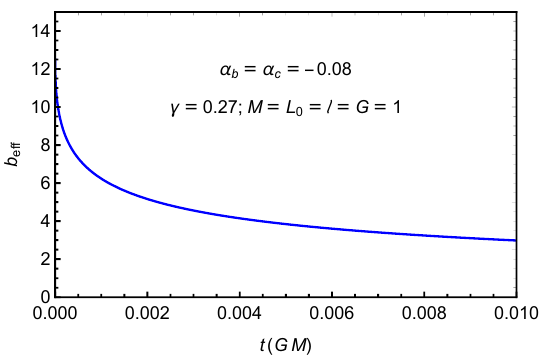
Figure 5 . Plot of the solution for b as a function of the Schwarzschild time t for model 3 close to the region that used to be the singularity. It is clear that b remains finite as t → 0 +